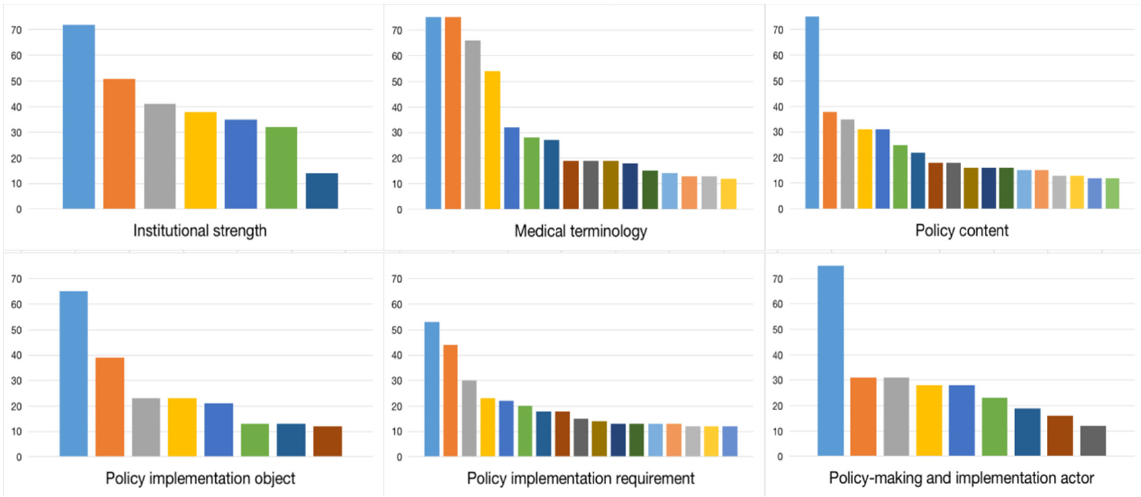
Figure 3. Word occurrences in the six categories. Source: Authors’ compilation. Note: the different color bars refer to the occurrences of each keyword in Table 3. For example, in the top left bar chart, the seven colors of light blue, orange, gray, yellow, blue, green, and dark blue (from left to right) represent the seven-word occurrences of “law-based governance”, “four confidences”, “armed forces”, “CPC centralized and unified leadership”, “the whole country working together”, “people-centered”, and “relying on people” (from high to low) in the second row (the category of institutional strength) of Table 3.